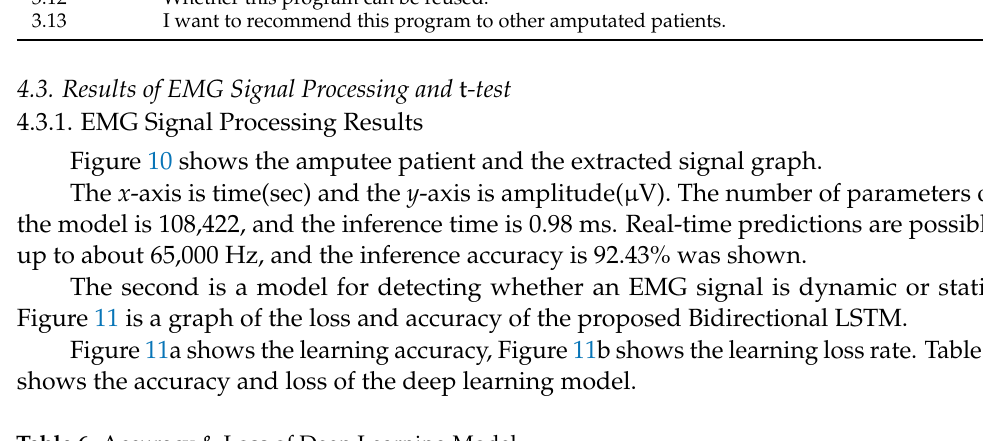
Table 6. Accuracy & Loss of Deep Learning